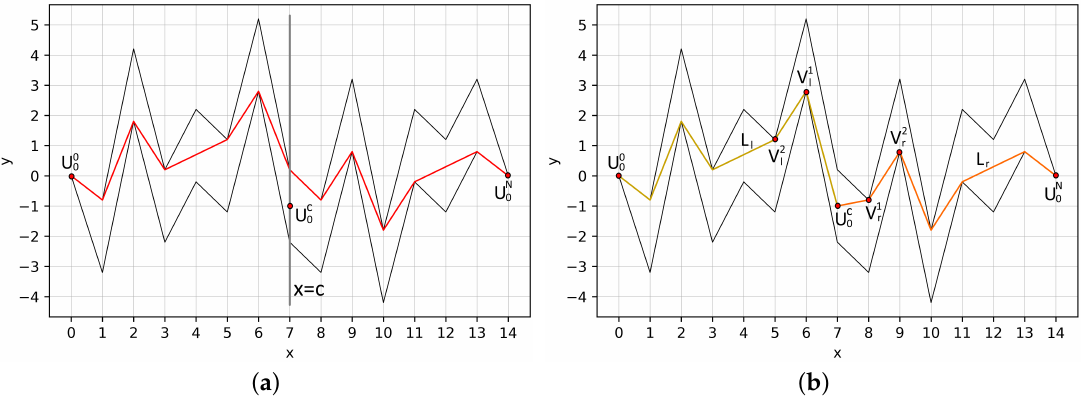
Figure 11. ( a ) The initial tube and its extremal curve L (red); ( b ) extremal curves L l (yellow) of the left subtube and L r (orange) of the right